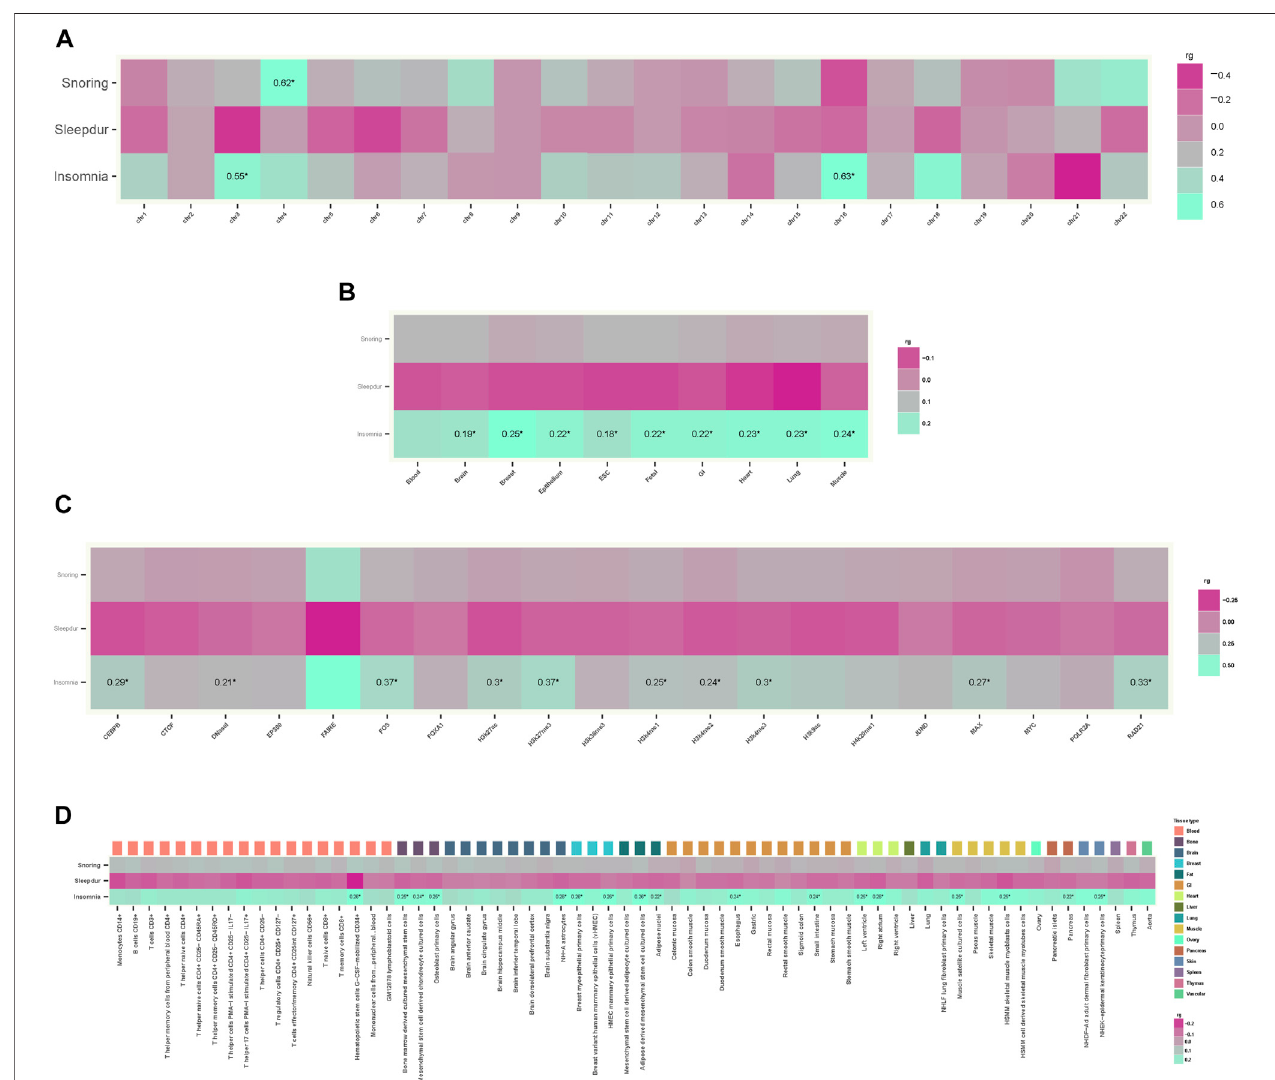
FIGURE 2 | Annotation-speci fi c genetic correlation. (A) Annotation-speci fi c genetic correlation between AD and SRPs by 22 chromosomes. Colors represent the estimated annotation-speci fi c genetic correlation between AD and SRPs (Insomnia, Sleepdur, and Snoring) using GNOVA; aquamarine for positive genetic correlation and violet red for negative genetic correlation at the corresponding annotation. The signi fi cant effects are labeled with r g and “ * ” ( p < 0.05/66). (B) Annotation-speci fi c geneticcorrelation betweenADandSRPsbytentissues.Colorsrepresent theestimatedannotation-speci fi cgeneticcorrelation betweenADand SRPs(Insomnia, Sleepdur, and Snoring) using GNOVA; aquamarine for positive genetic correlation and violet red for negative genetic correlation at the corresponding annotation. The signi fi cant effects are labeled with r g and “ * ” ( p < 0.05/30). (C) Annotation-speci fi c genetic correlation between AD and SRPs by 20 functional categories. Colors representtheestimatedannotation-speci fi cgeneticcorrelationbetweenADandSRPs(Insomnia,Sleepdur,andSnoring)usingGNOVA;aquamarineforpositivegenetic correlationandvioletredfornegativegeneticcorrelationatthecorrespondingannotation.Thesigni fi canteffectsarelabeledwith r g and “ * ” ( p < 0.05/60). (D) Annotation- speci fi c genetic correlation between AD and SRPs by 66 epigenetic cell types. Colors represent the estimated annotation-speci fi c genetic correlation between AD and SRPs (Insomnia, Sleepdur, and Snoring) using GNOVA, aquamarine for positive genetic correlation and violet red for negative genetic correlation at the corresponding annotation. The signi fi cant effects are labeled with r g and “ * ” ( p <